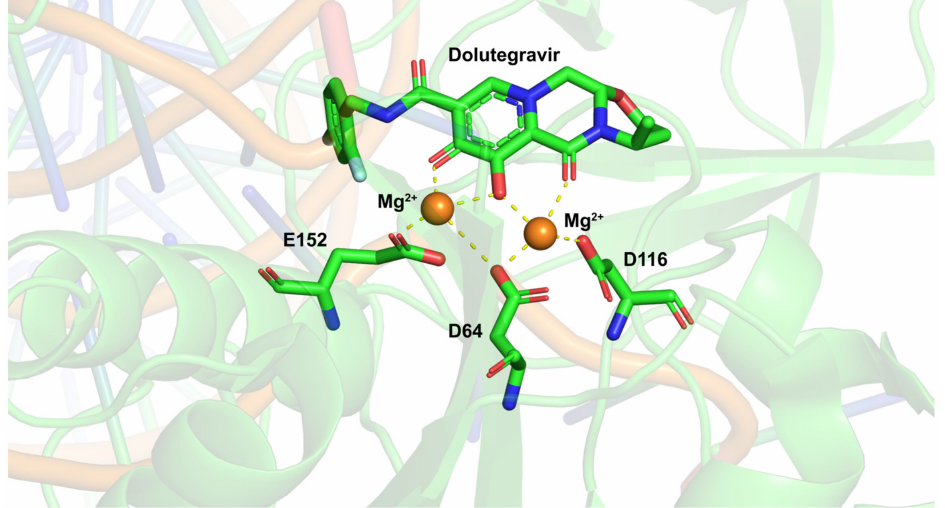
Figure 3. Mode of action of dolutegravir targeting HIV-1 integrase. This figure shows the 3D structure of the HIV-1 IN catalytic site complexed with DTG. The three coplanar oxygen atoms (in red) of DTG chelate Mg 2+ cations (in orange) in the intasome active site constituted by the D116, D64 and E152 residues. The length and flexibility of the linker bridging the tricyclic metal-chelating core and the difluorophenyl ring are responsible for the high potency of inhibition of DTG. This 3-D structure was prepared with The PyMOL Molecular Graphics System, Version 1.3, Schrödinger, LLC using the PDB (protein data bank) 6VDK [53]. Red: oxygen atoms, blue: nitrogen atoms. The half-life (T 1/2 ) of the INSTI on the IN/DNA complex is an important parameter. Indeed, a high T 1/2 of the compound leads to a higher inhibition of the complex over time. The half-life, in theory, represents the time it takes for a drug to bind to its target, which is directly proportional to the drug’s ability to exert its